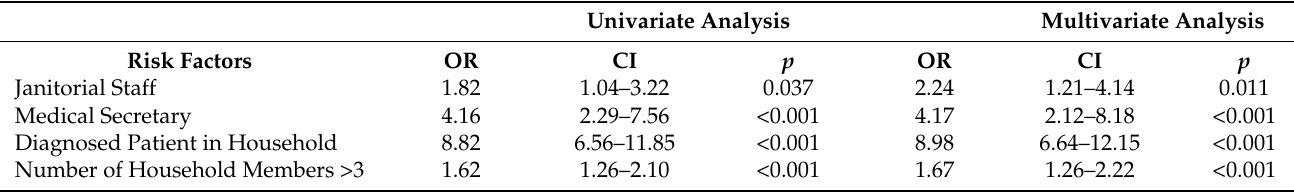
Table 2. The predictors of SARS-CoV-2 infection among HCWs. Univariate Analysis Multivariate